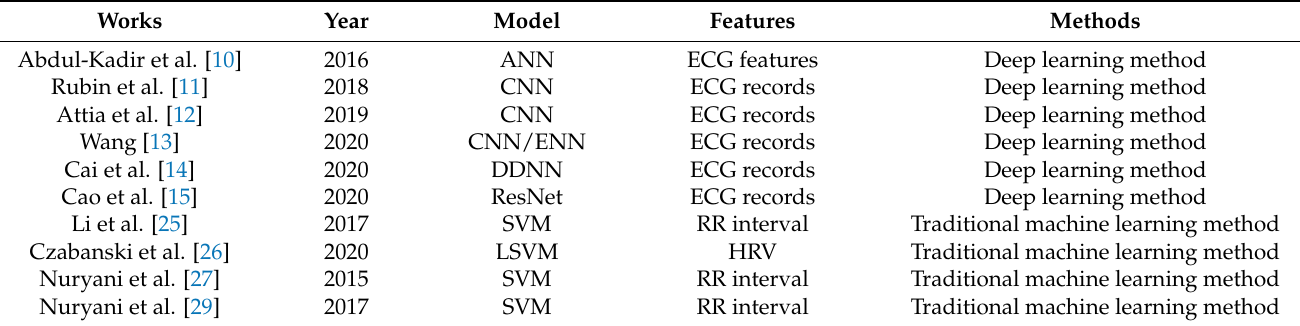
Table 1. Summary of related work in recent